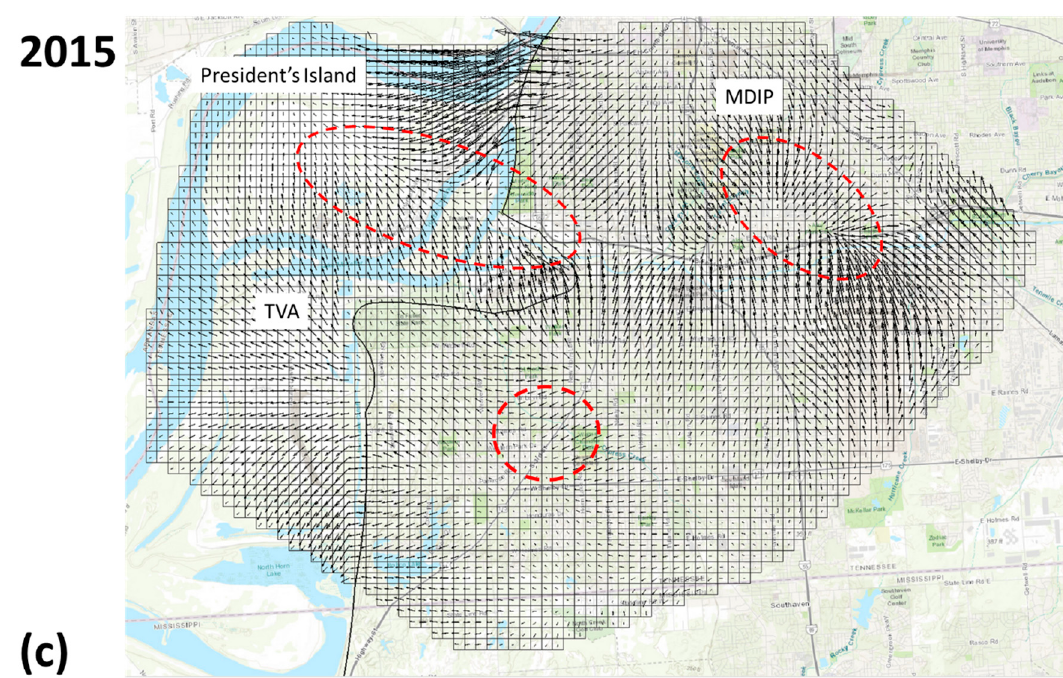
Figure 10. ( a – c ) maps show the Shallow aquifer groundwater velocity vectors for 2005, 2010, and 2015, respectively. The magnitudes of the velocities are proportional to the length of the arrows. Three zones where the groundwater velocity vectors are converged are shown. The presence of a breach in these zones are more probable than that of the surrounding areas.